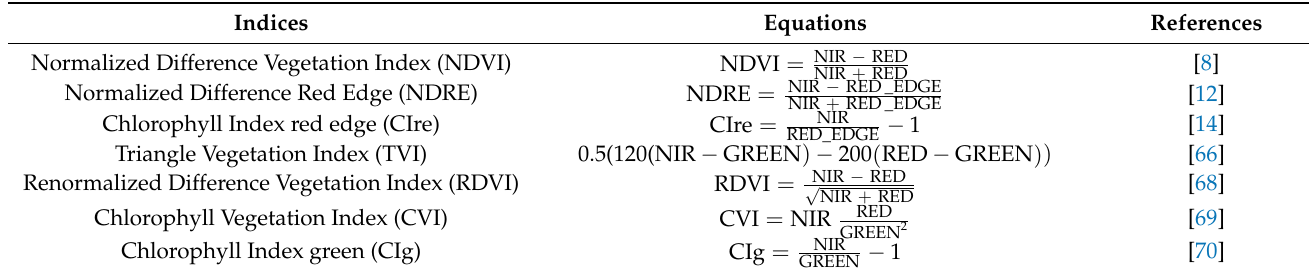
Figure 12. Vegetative indices: ( a ) Normalized Difference VI (NDVI) and ( b ) Chlorophyll Index red edge (CIre). Table 2. Vegetation indices generated from the image processing